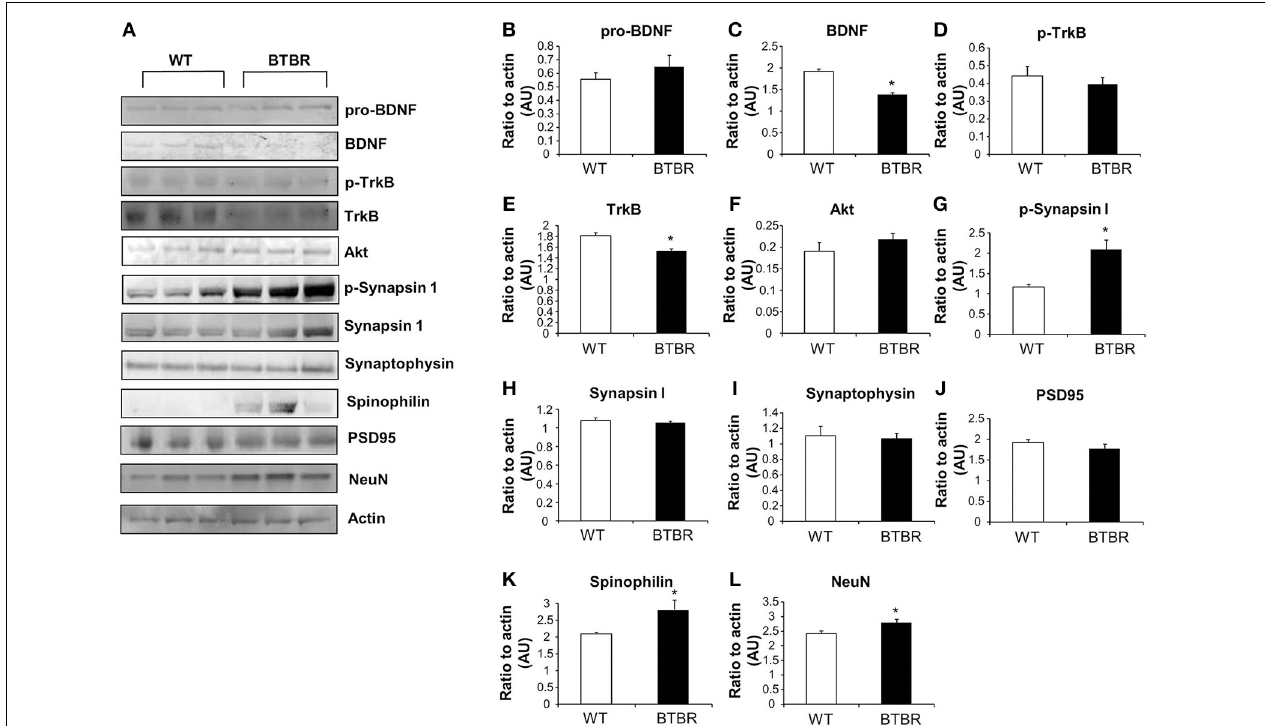
FIGURE 2 | Protein expression in wild type and BTBR mouse cortex. Western blotting was performed using mouse cortical protein lysates (A) . Protein levels were measured in BTBR and control mice with respect to the following proteins in the cortex: pro-BDNF (B) , mature BDNF (C) , phospho-TrkB (D) , total TrkB (E) , Akt (F)